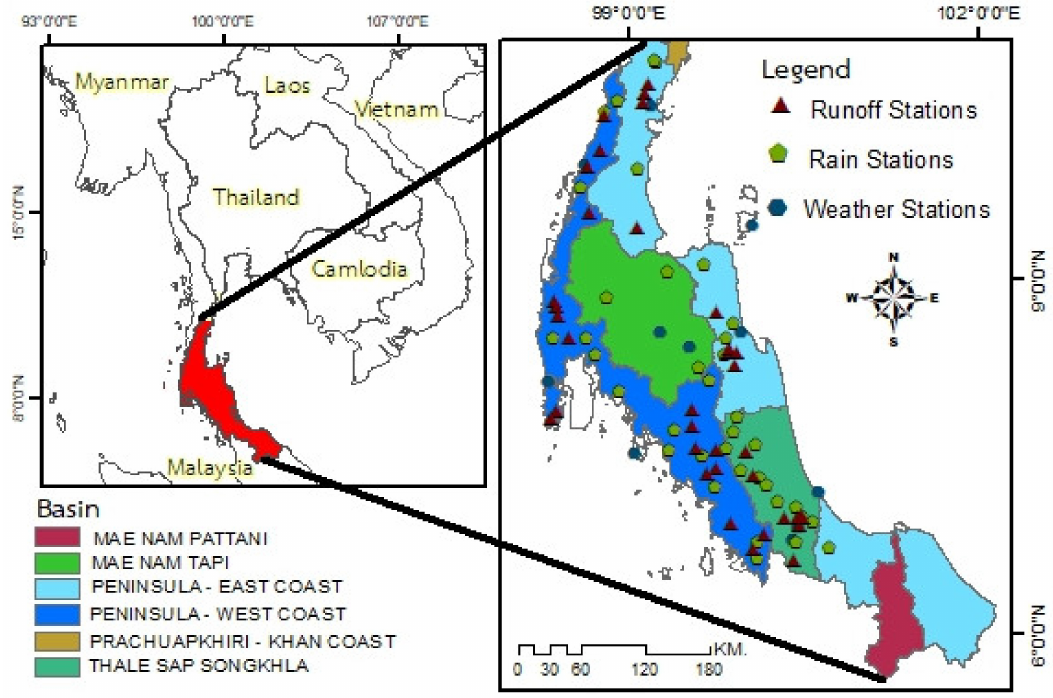
Figure 1. Location of rainfall, runoff, and weather stations selected in the southern basin of